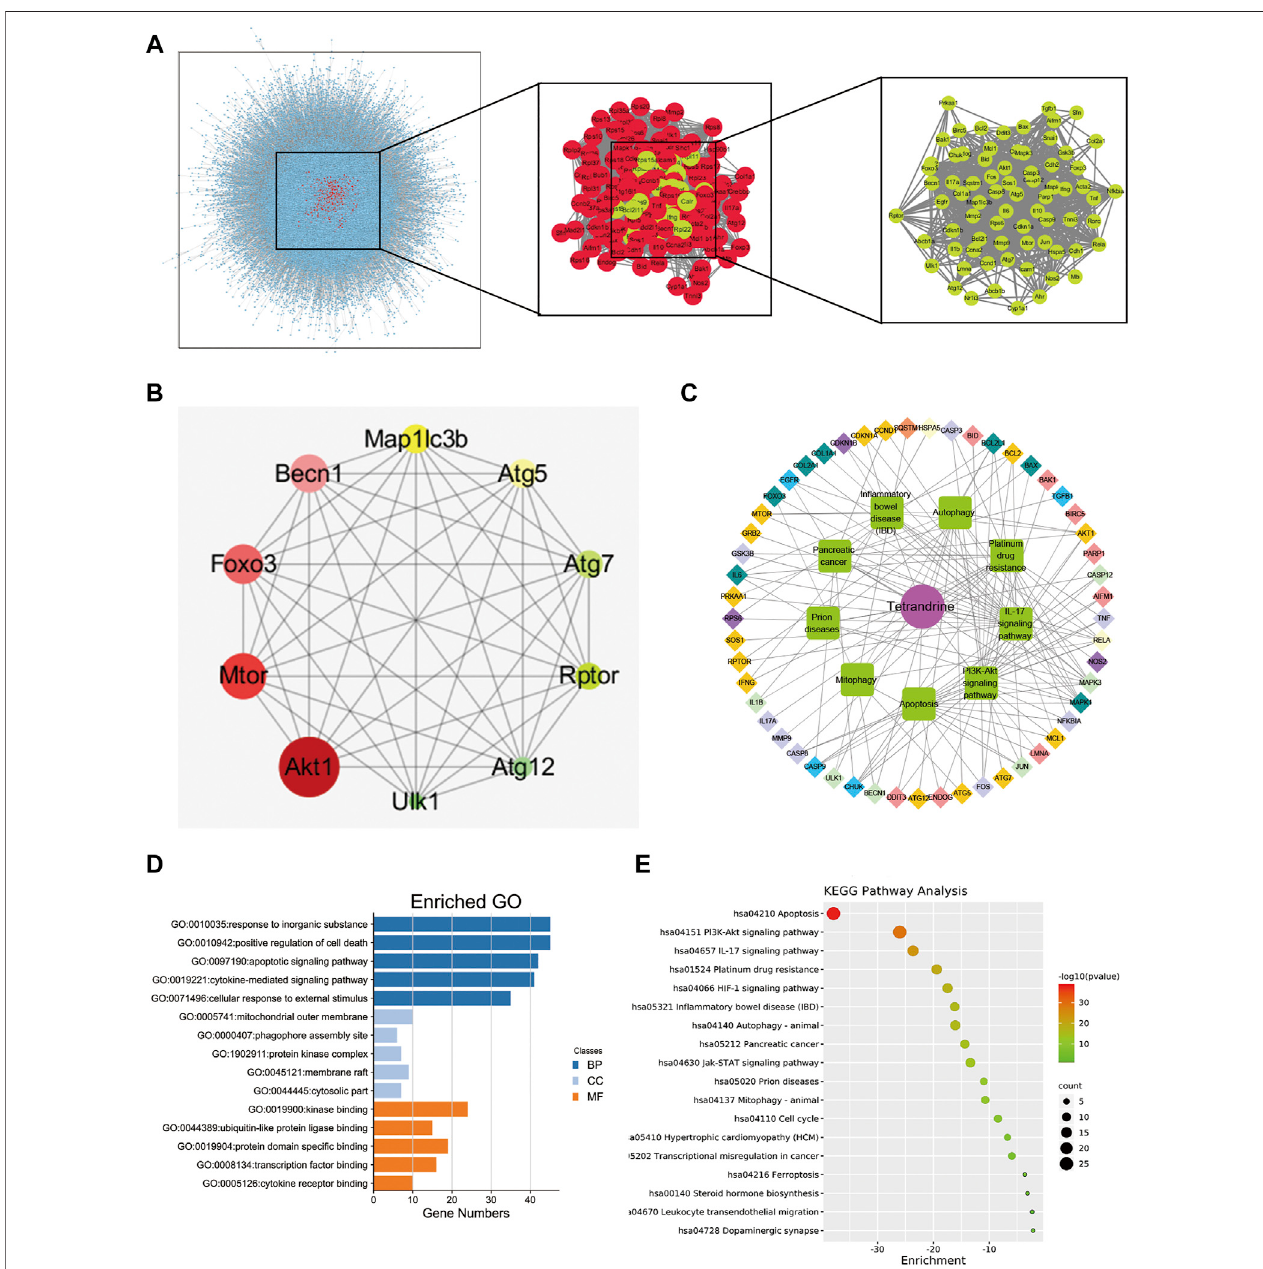
FIGURE2| AnalysisofTET ’ stargetsonpulmonary fi brosisbasedonnetworkpharmacology. (A) protein — proteininteraction(PPI)networksofactiveingredientsof TET for thetreatmentofpulmonary fi brosis. Each node representstherelevantgenes, theedge meanslinethickness indicates thestrength ofdatasupport. (B) Hub top 10 genes in PPI network, the lighter the color, the higher the score; the larger the diameter, the higher the score. (C) Representative networks assembled by predicted TET targets. Diamonds in various colors nodes represent the targets for TET identi fi ed through target mapping. Green nodes represent signaling pathways or processes.Targetsareconnectedwithpathwaysorprocesseswithinnercircleinthecorrespondingcolor. (D) TheGOanalysiswasdiscoveredwiththetop fi veenriched conditions in the biological process (BP), cell component (CC), and molecular function (MF) categories. (E) KEGG pathways of target genes.